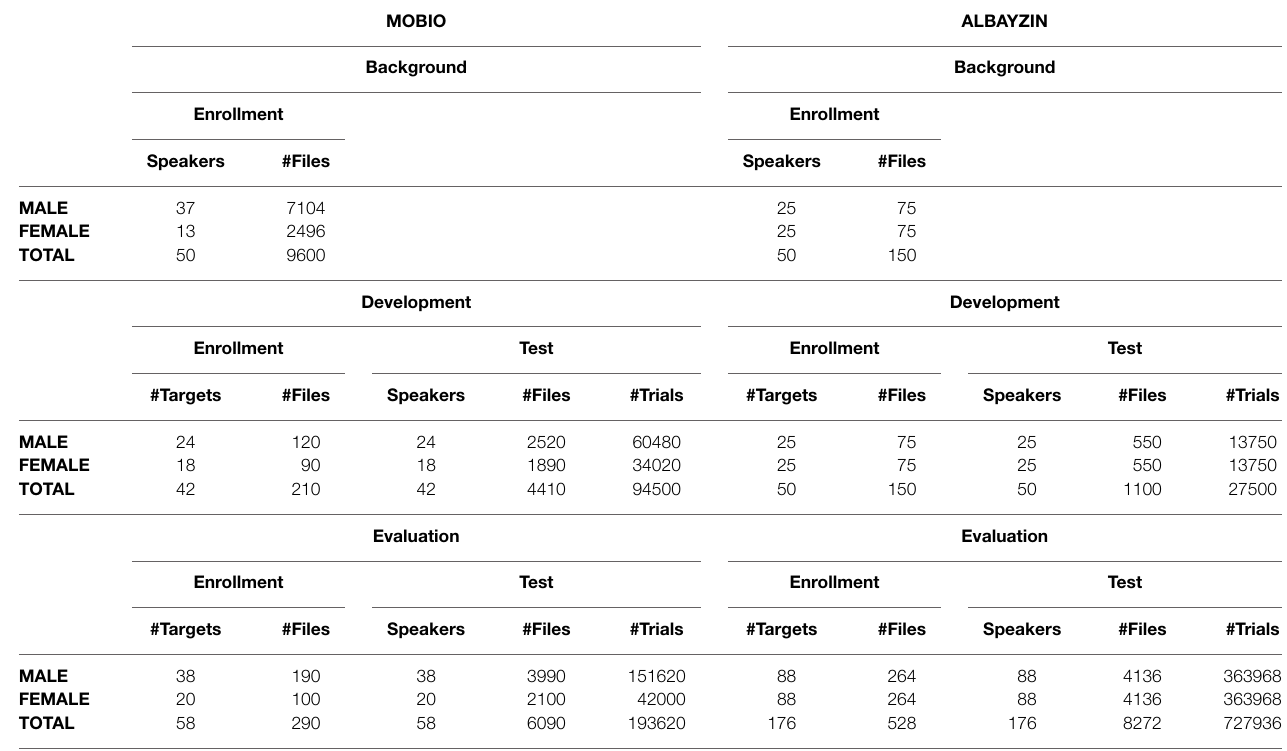
TABLE 1 | Description of the contents of the different subsets for the different scenarios .